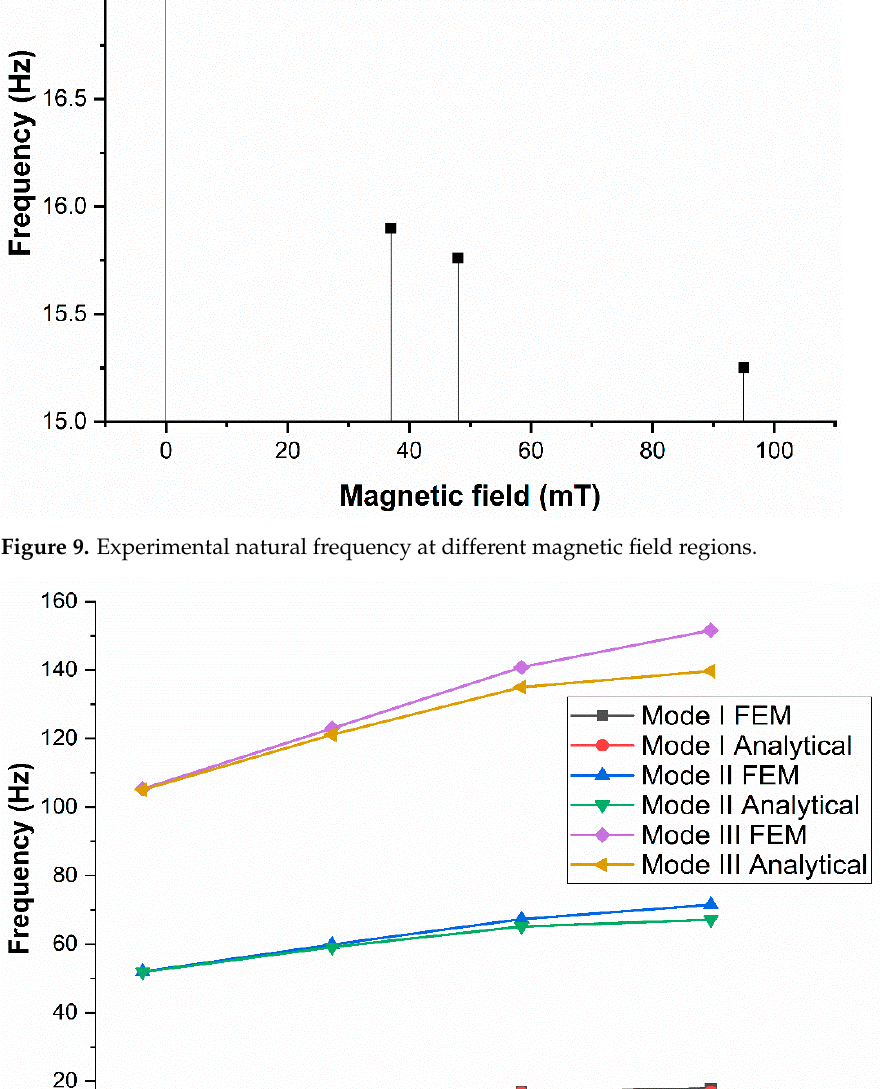
Figure 10. Frequency response under different magnetic intensities.